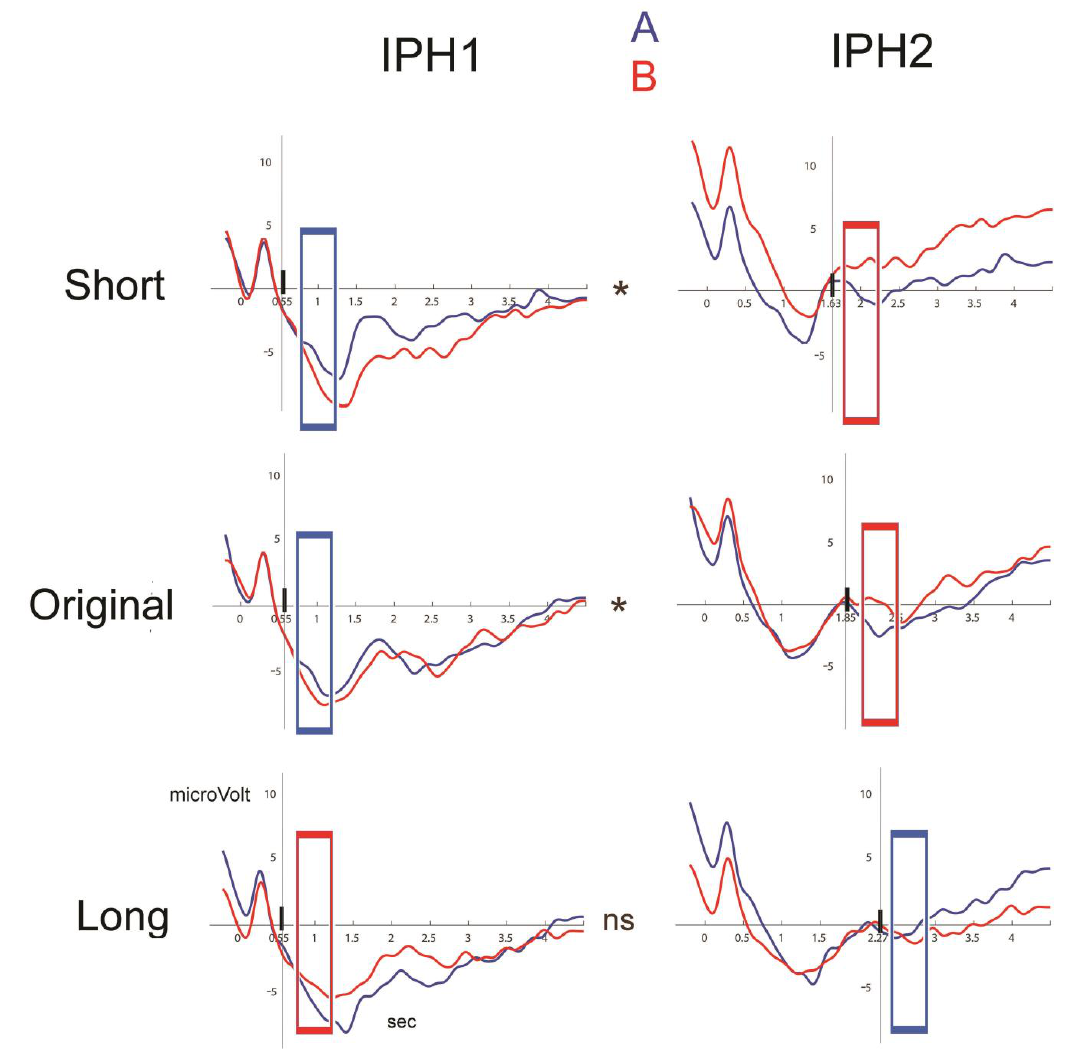
Figure 4. ERPs to IPH1 and IPH2 boundaries (onset of last stressed syllable in the IPH) across the three levels of pre-boundary lengthening. Baseline corrections were applied to the time points marking the onset of the last stressed syllable of both IPH1 and IPH2. The waveforms represent average voltage for the right-central region. Asterisks and ns (non-significant) refer to the significance of the IPH x version interaction (CPS effect). Rectangles indicate the 500 ms time window used for analysis: red rectangles indicate B > A and blue ones A > B.